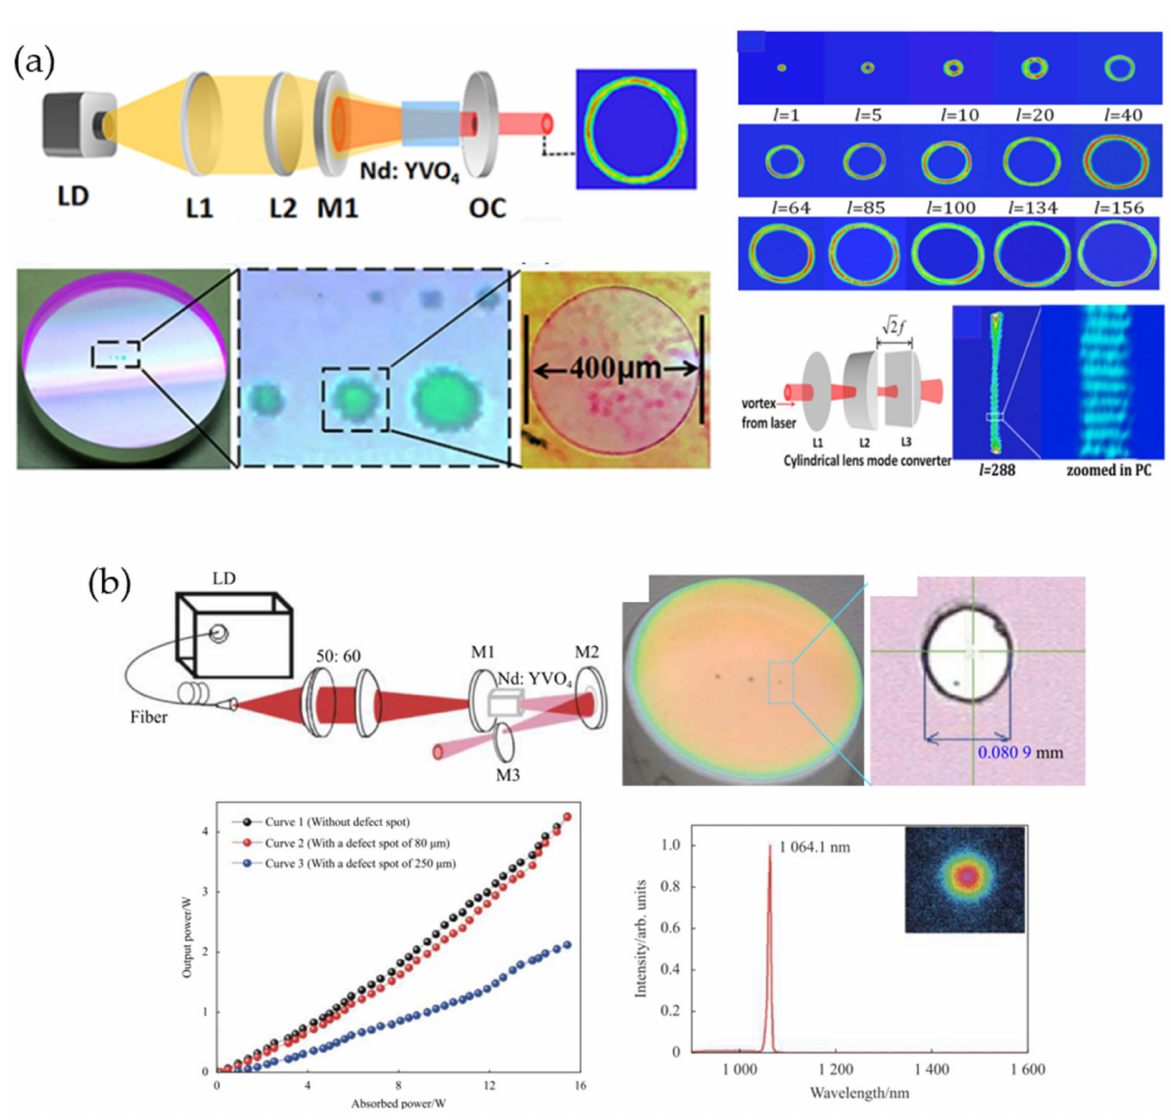
Figure 3. Vortex lasers using defected mirror. ( a ) Generation of high-charge optical vortices up to 288th order directly by laser cavity mirror etching. Reprinted with permission from [114] © 2018 The Authors. ( b ) A LD-end-pumped V-type Nd:YVO 4 vortex laser. Reprinted with permission from [115] © Infrared and Laser